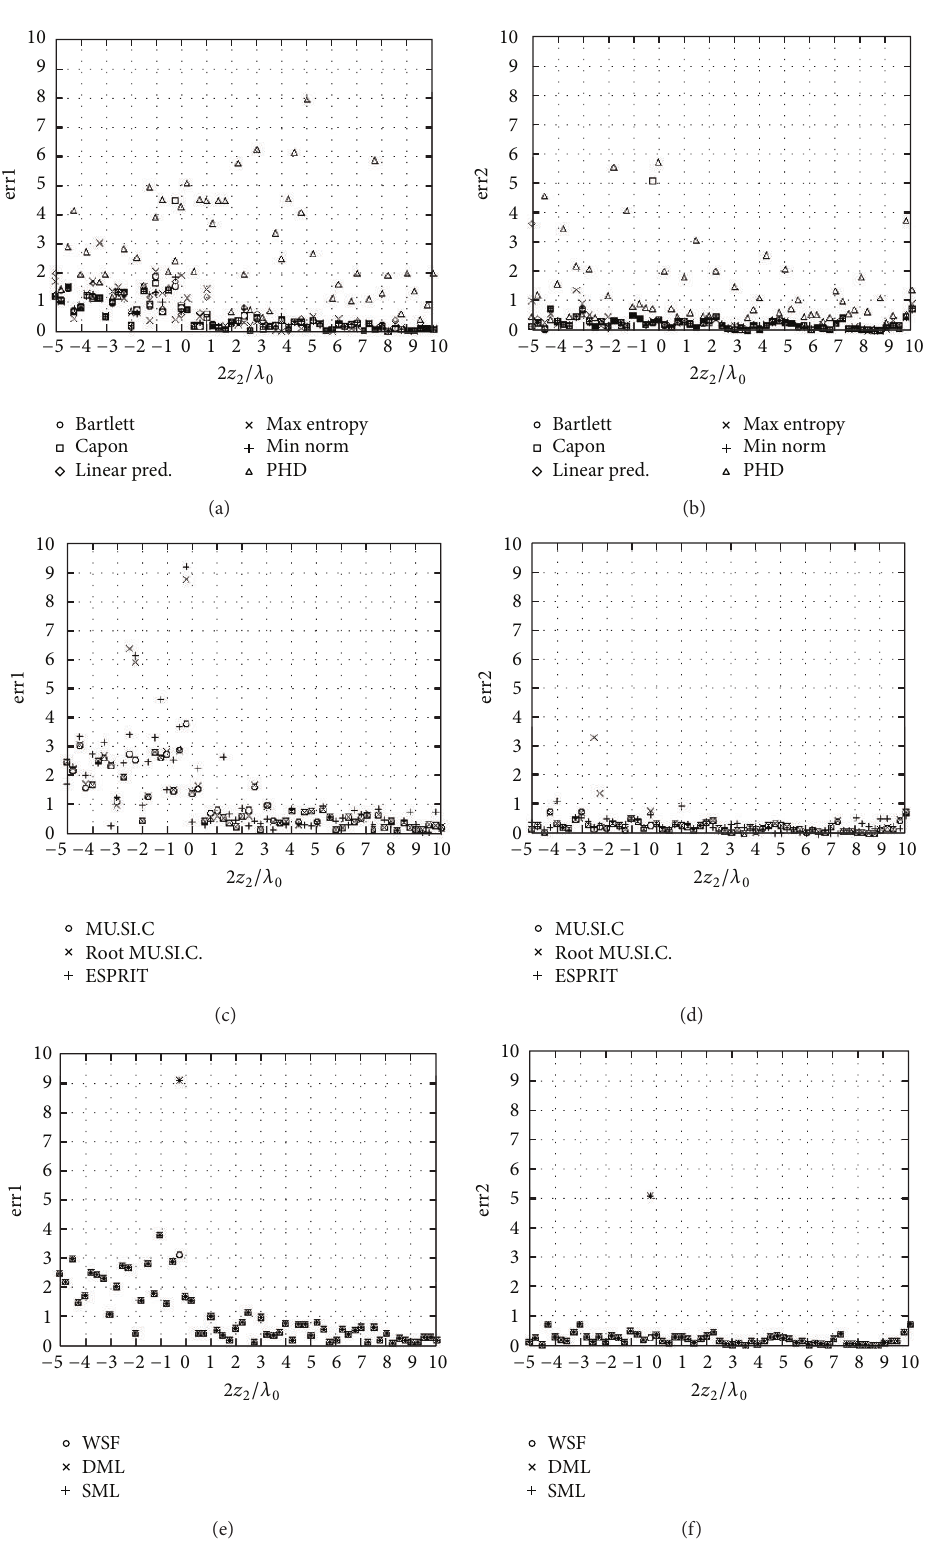
Figure 3: Same as in Figure 2, for two air cavities (𝜀 𝑟1 = 𝜀 𝑟2 = 1)